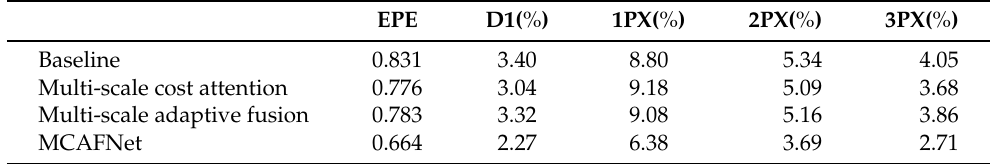
Table 1. Ablation experiment of network